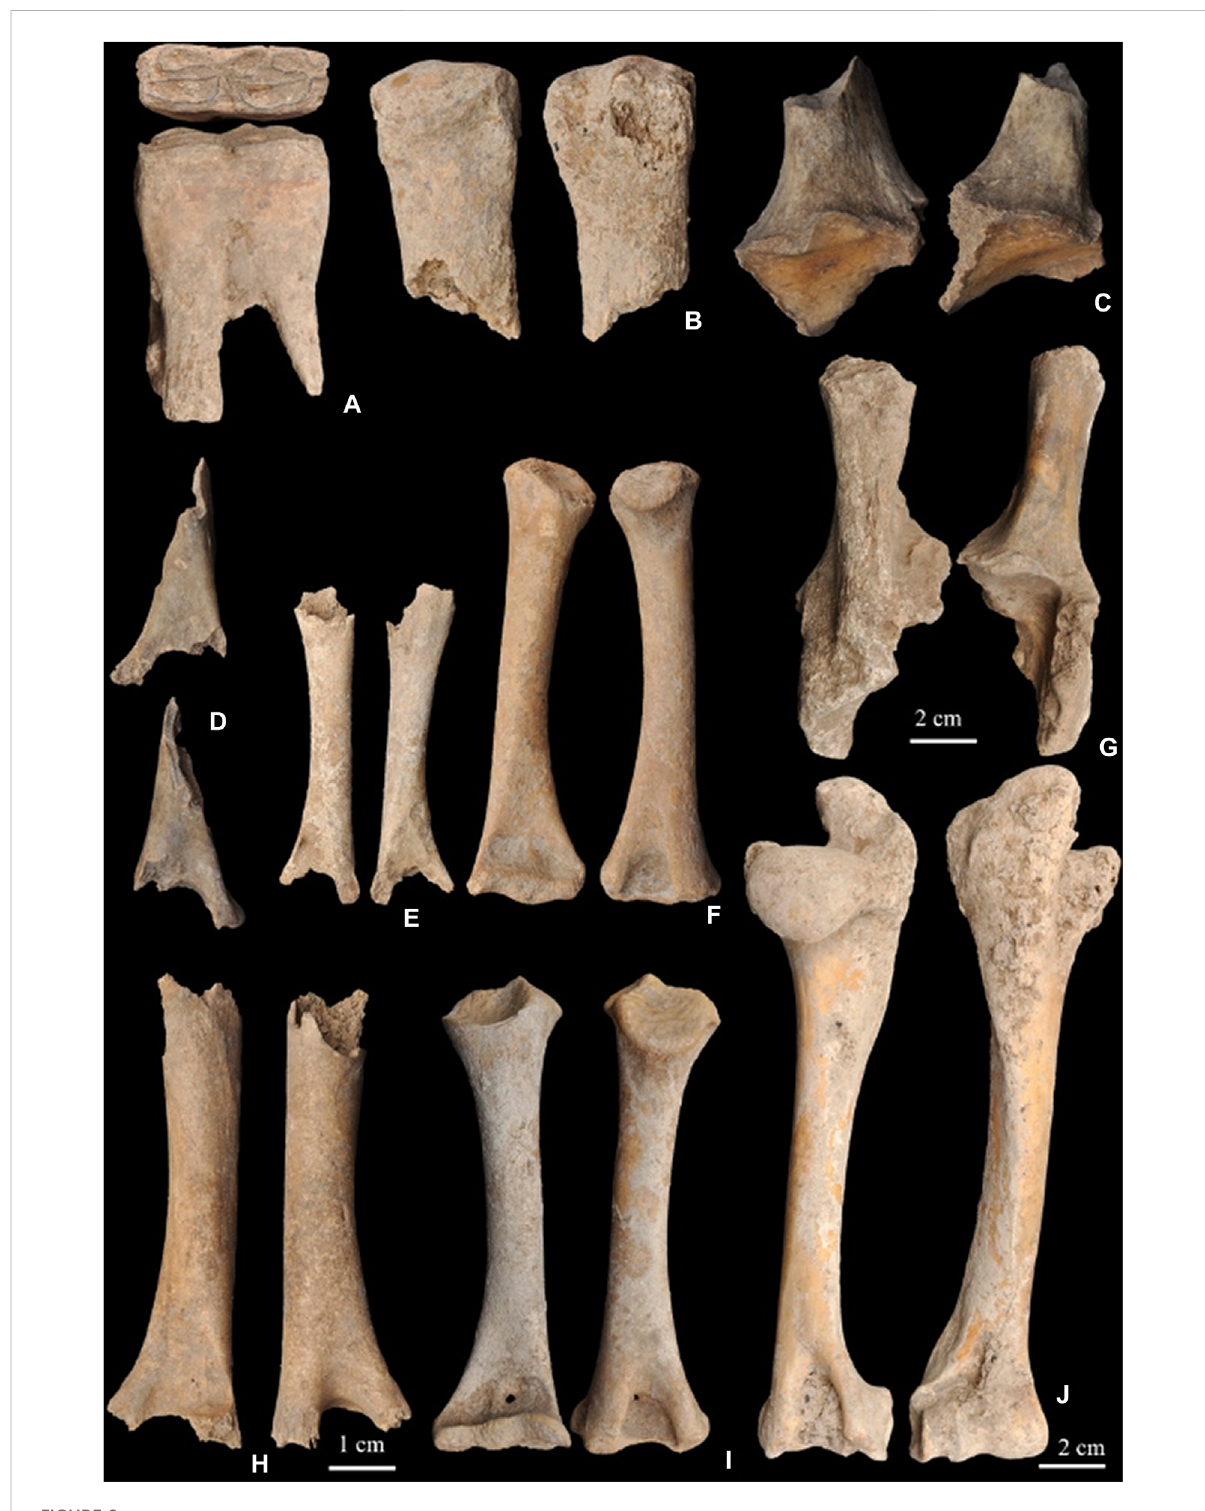
FIGURE 2 Faunal remains from layer IV 2 . (A) (Site # 3475) equid lower deciduous tooth (dp3). (B) (Site # 2969) brown bear metatarsal. (C) (Site # 3166) bovidcalcaneum. (D) (Site#3148)ovicapridhumerus. (E) (Site#3147)ovicapridhumerus. (F) (Site#2760)ovicapridhumerus. (G) (Site#2444)bovid calcaneum. (H) (Site # 3167) ovicaprid humerus. (I) (Site # 2872) ovicaprid humerus. (J) (Site # 3279) ovicaprid